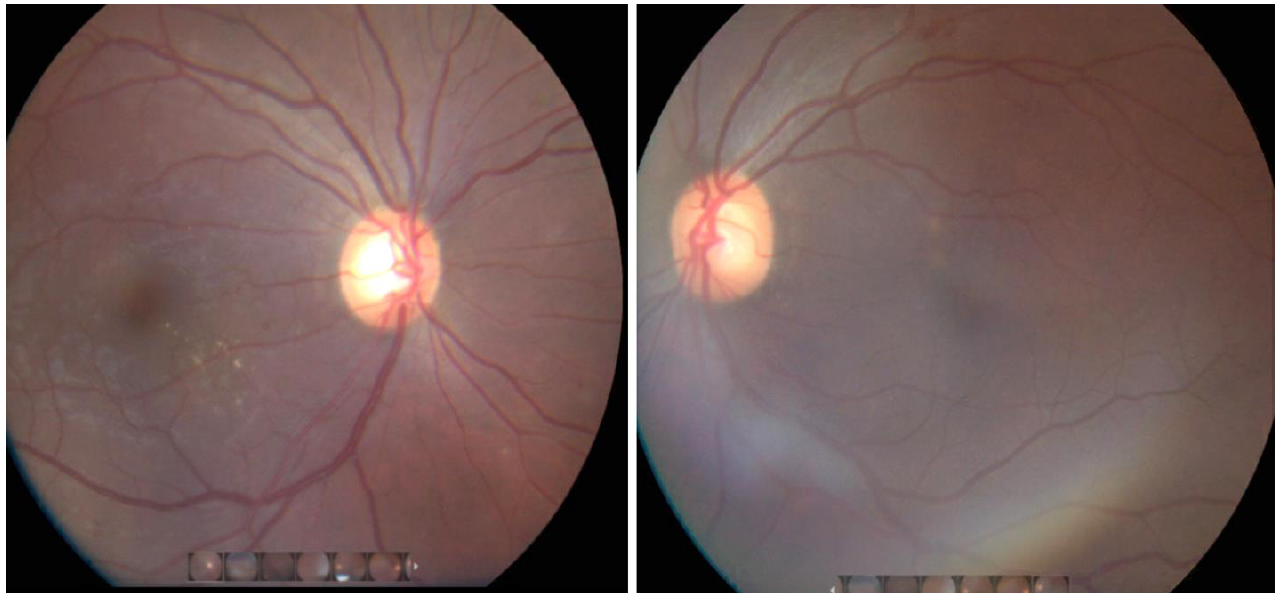
Figure 9. Fundoscopic findings. ( Left ): The right eye shows a few small circular flat creamy yellowish lesions along inferior and superior arcades, one lesion more pronounced along inferior temporal arcade, and a few pinpoint yellow lesions just inferior to fovea. ( Right ): The left eye showed a few circular creamy yellowish lesions along arcades, with one more prominent along the inferior arcade and few smaller circular, subtle yellow-white lesions just superior to the fovea.